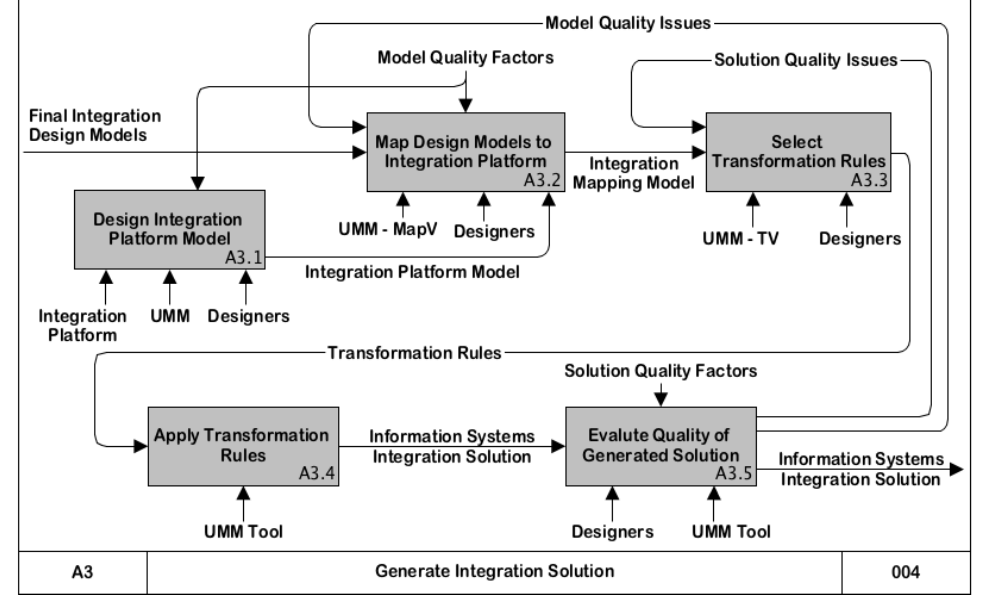
Figure 5. Details of the third stage of the methodology. Level A3 of the IDEF0